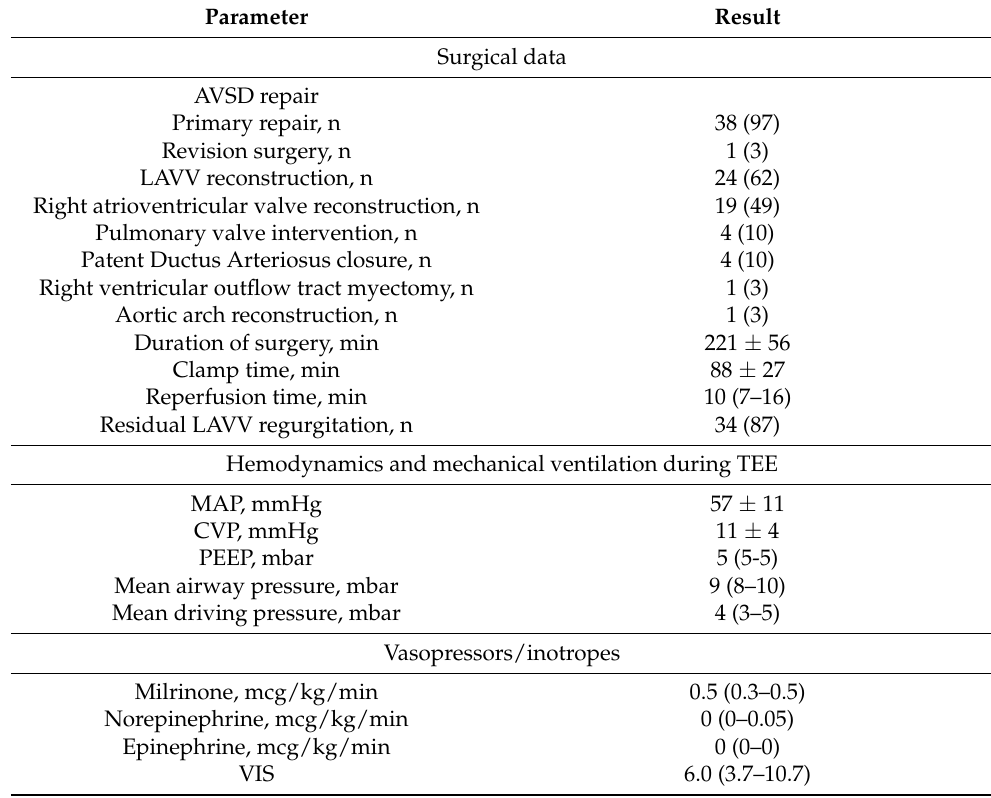
Table 2. Surgical and intraoperative data.